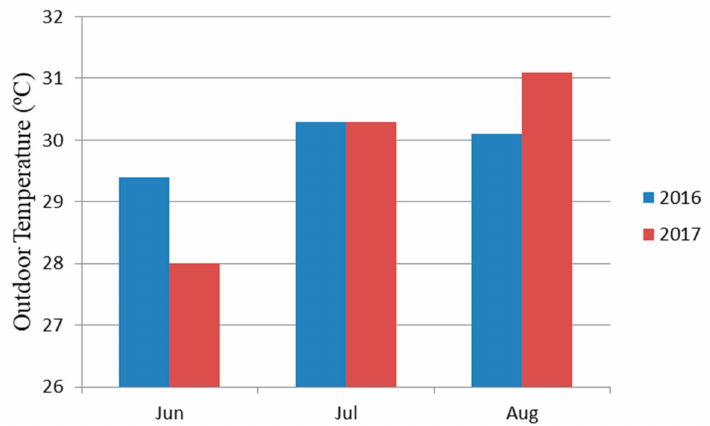
Figure 9. Outdoor temperature distribution.